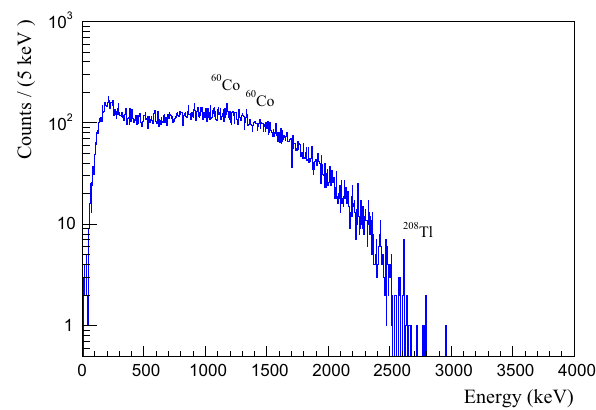
Fig. 17 Summed alpha region using 19/20 detectors. No RLY cut applied. (For details see text.)